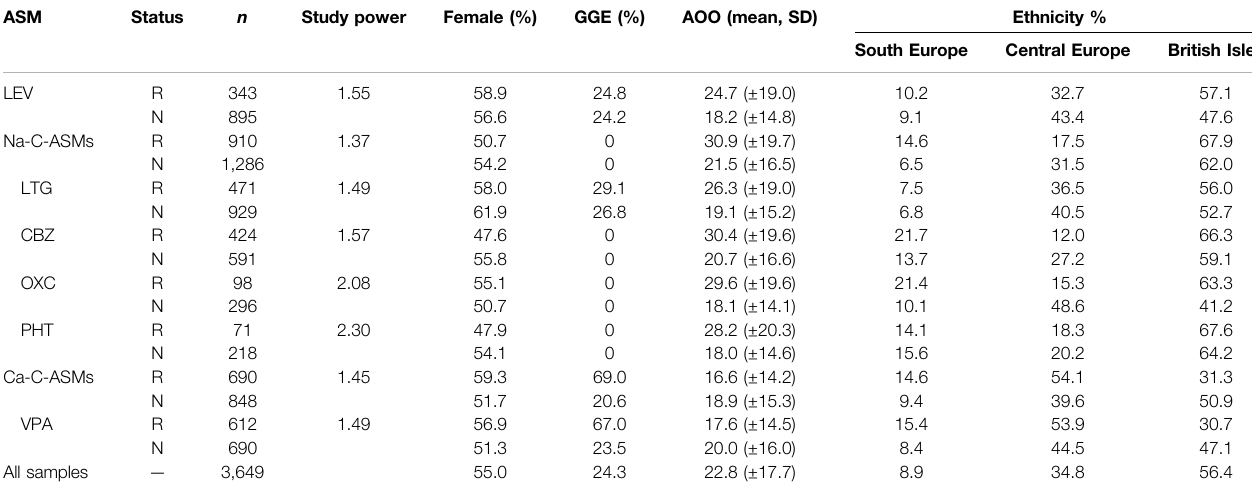
TABLE 1 | Sample numbers, estimated power, and clinical details for GWAS